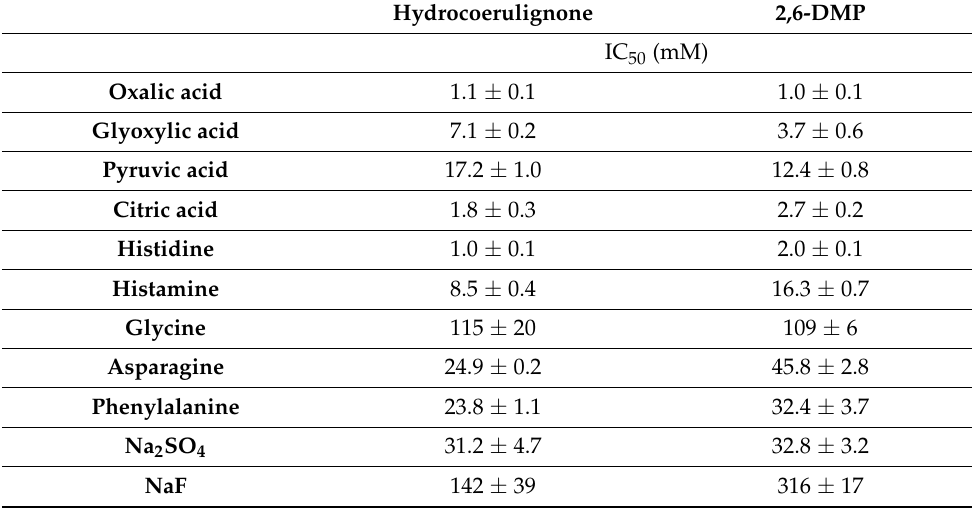
Table 3. IC 50 values (inhibitor concentration at 50% residual